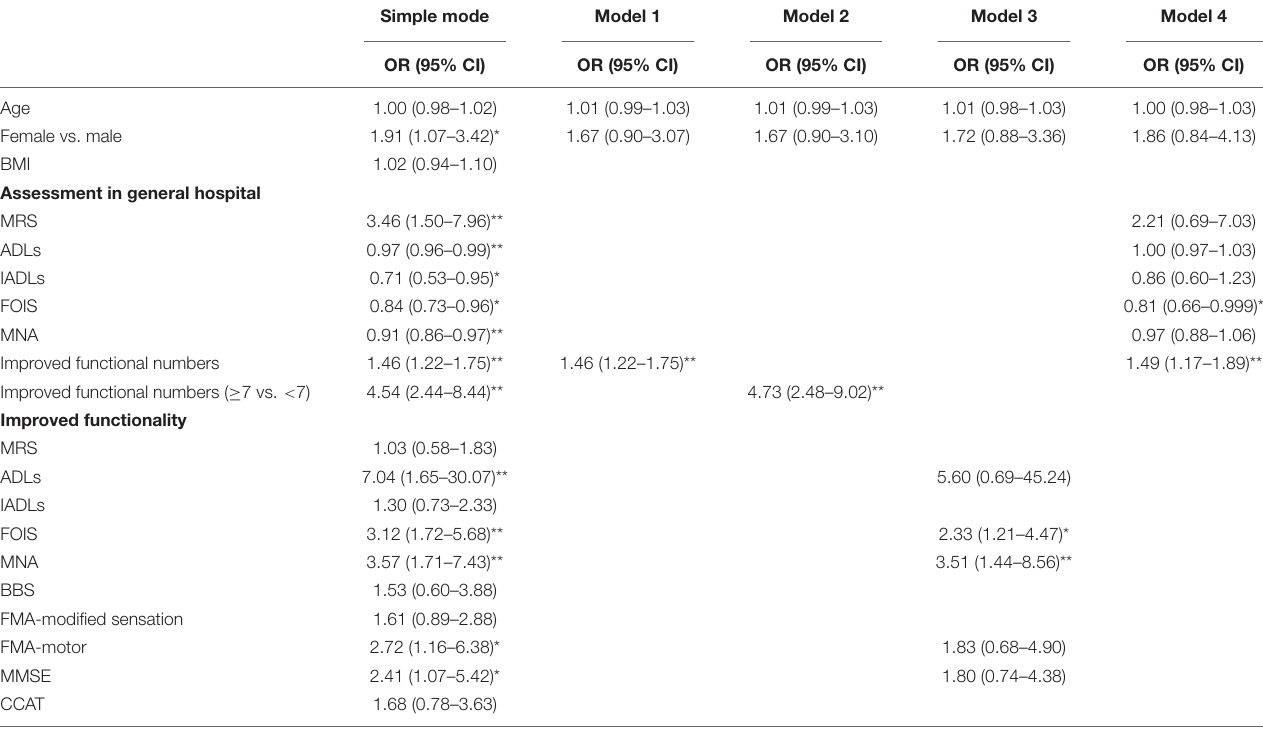
TABLE 4 | Predictors of length of stay in patients with